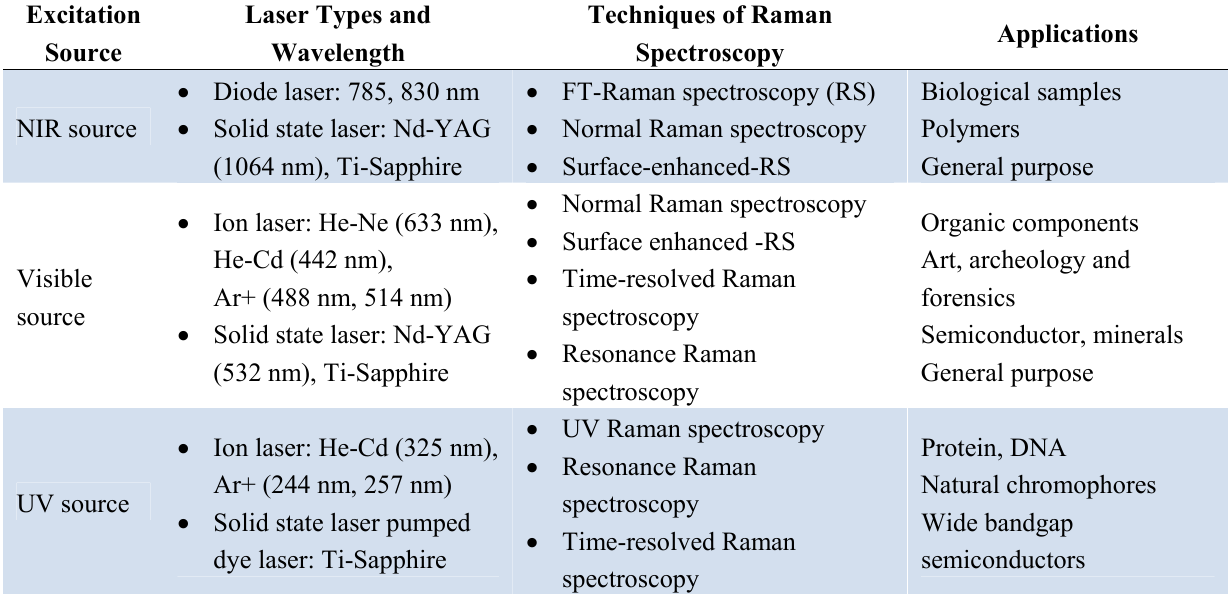
Table 3. Commercial lasers used in Raman spectrometers and